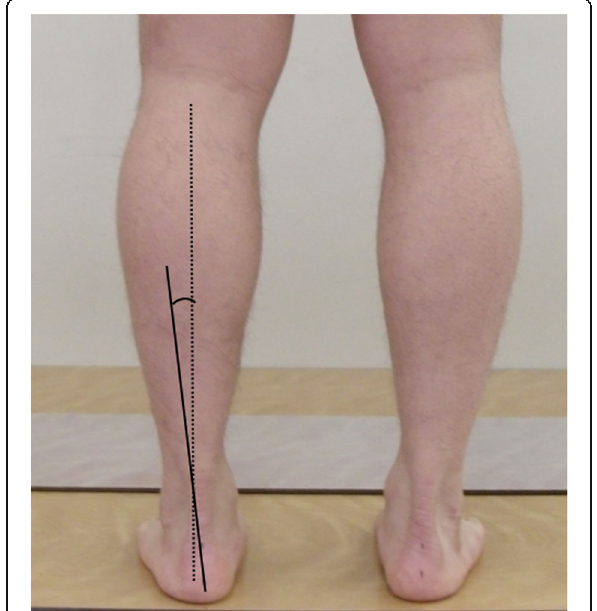
Fig. 1 Measurement of W-LHA. Subjects were placed in the weight- bearing position and we measured the angle between the lower leg line and calcaneus line using imageJ